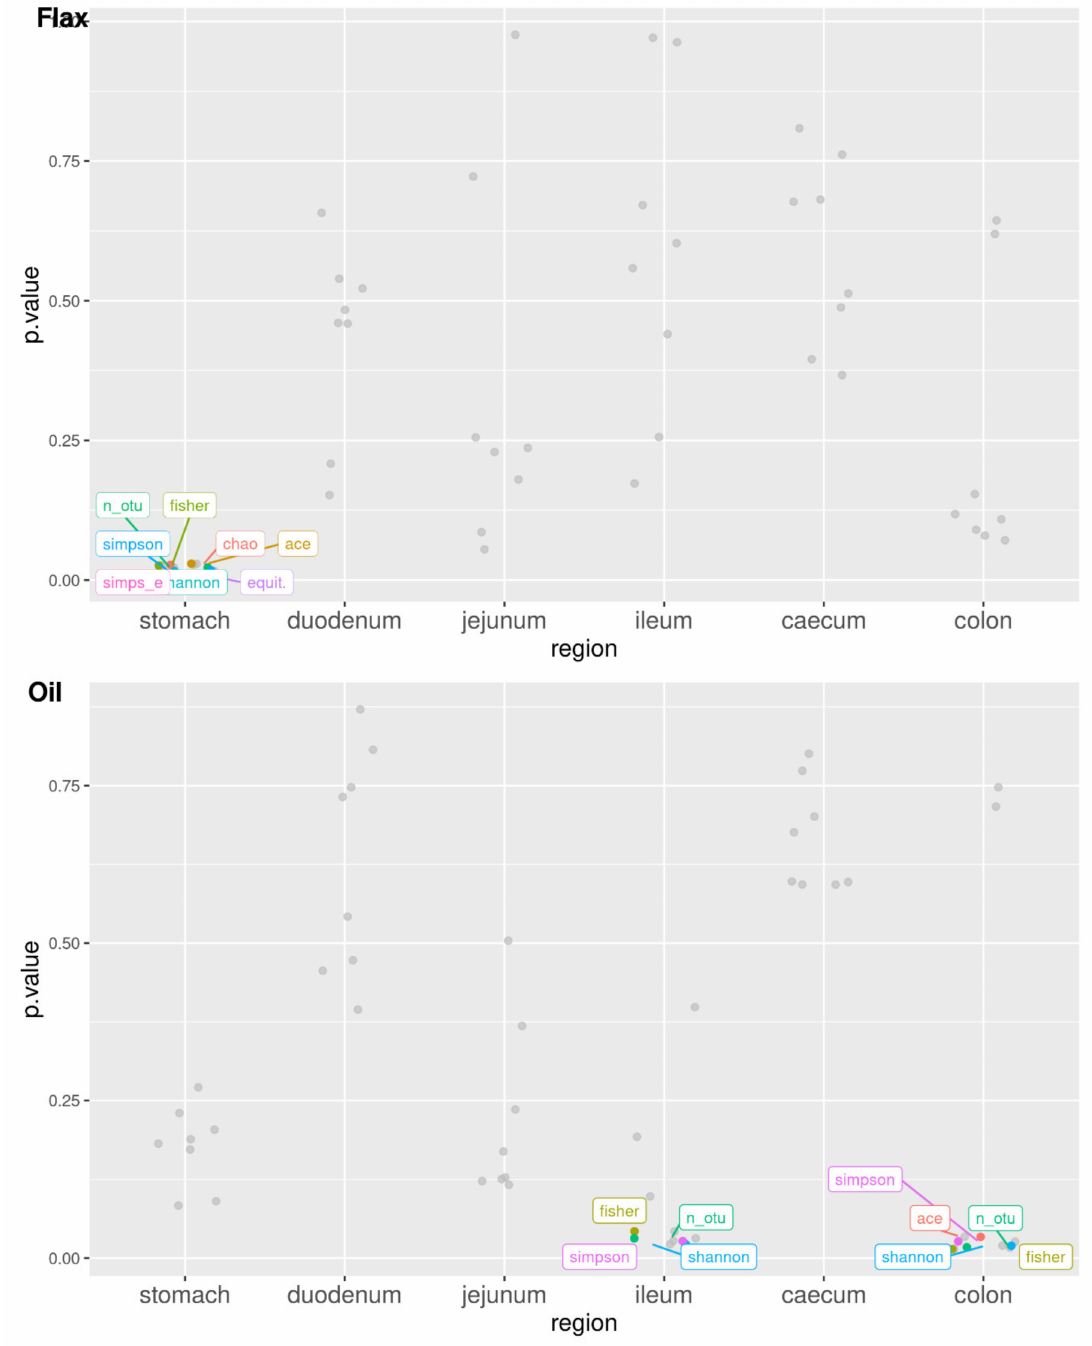
Figure 5. Significance of treatment differences for the alpha diversity indices along the rabbit’s digestive tract (region; threshold: p < 0.05) for diets supplemented with flaxseed (flax) and fish oil (oil). Linear model of the form: alpha index = mu + treatment + e for each gastrointestinal tract (tissue)